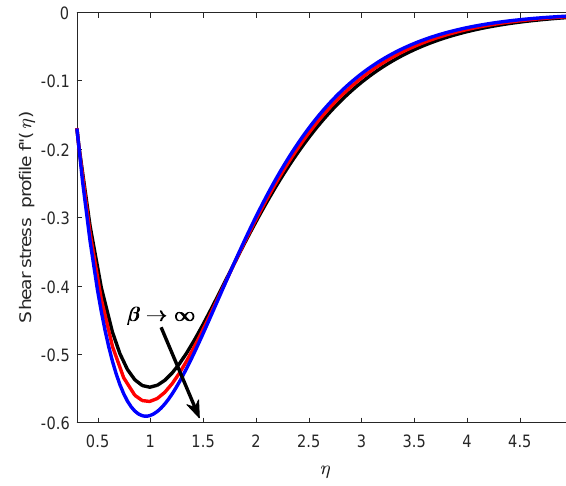
Figure 13: Variation of shear stress profile with large magnitudes of Casson fluid